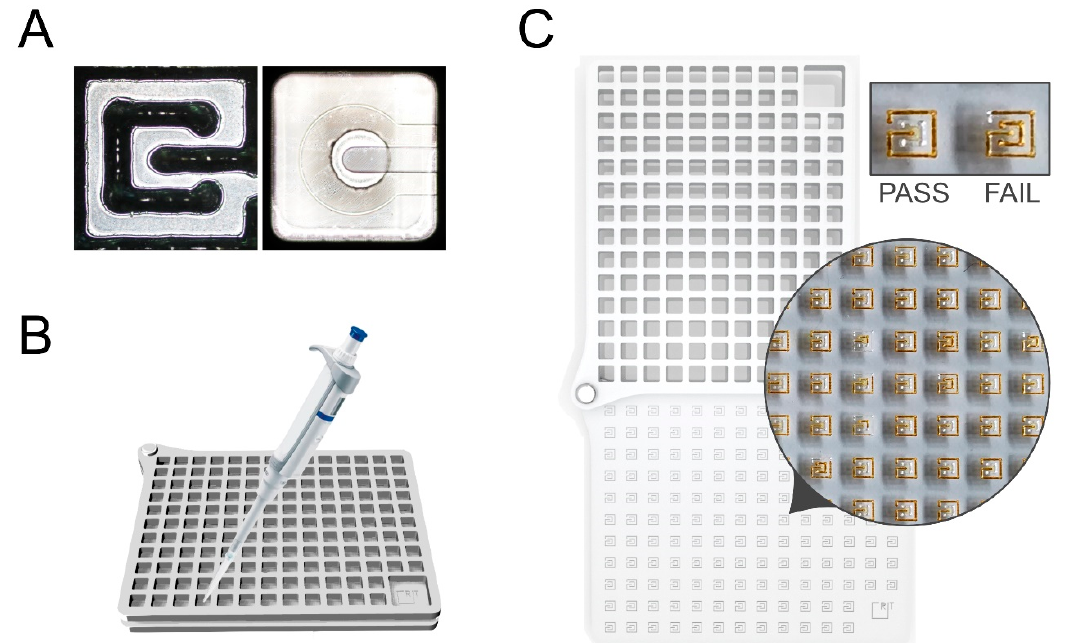
Figure 4. Validation protocol. ( A ) Comparison of the inlet of the MT single tester cell (on the left) and of the commercial microfluidic plate (OrganoPlate ® 2-lane, on the right) (objective 4×); ( B ) Graph representation of the filling process of the MT device; ( C ) MT tester cells on the exercise plate that are filled with the staining solution (1.3 µL Betadine ® ), at the end of the validation test (representative image). On the top right, a magnification of representative images of one correctly filled cell (pass), and one failed cell (fail).